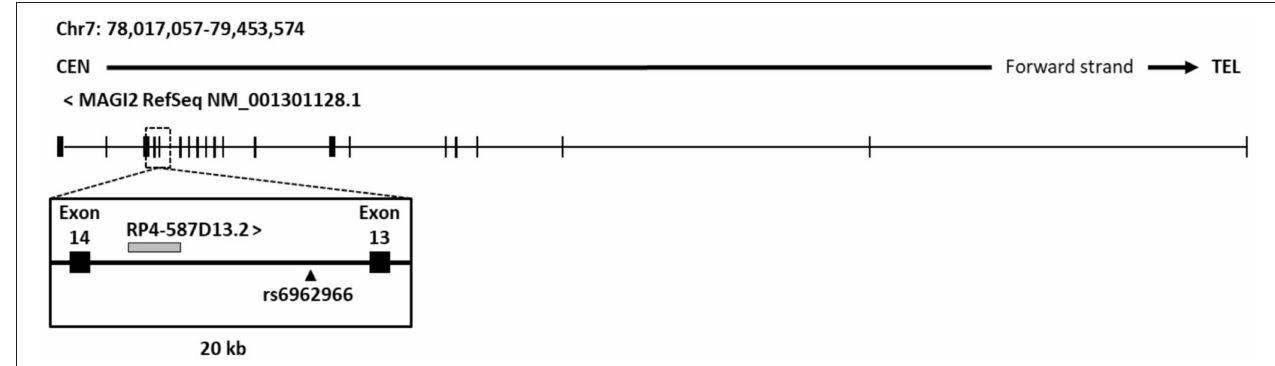
FIGURE 2 | Characterization of RPL4-587D13.2 expression in human tissues and the C2BBe1 cell line. (A) mRNA expression of MAGI2 and RPL4-587D13.2 in RNA from 9 human tissues. Values are represented relative to the tissue with the highest expression levels (brain). (B) Subcellular localization of RPL4-587D13.2 in C2BBe1 cells. The box-plots show the ratio of nuclear to whole cell transcripts, represented as the maximum and minimum values and the mean ( n = 3); LNC13 and RPLP0 are used as nuclear and cytoplasmic controls, respectively. (C) Representative western blot and (D) quantification of MAGI2 protein levels in C2BBe1 cells silenced for RPL4-587D13.2 (siRNA_1 and siRNA_2). The mean and standard deviation of MAGI2 expression relative to the control siRNA are shown ( n = 3) (*0.01 < p < 0.05).